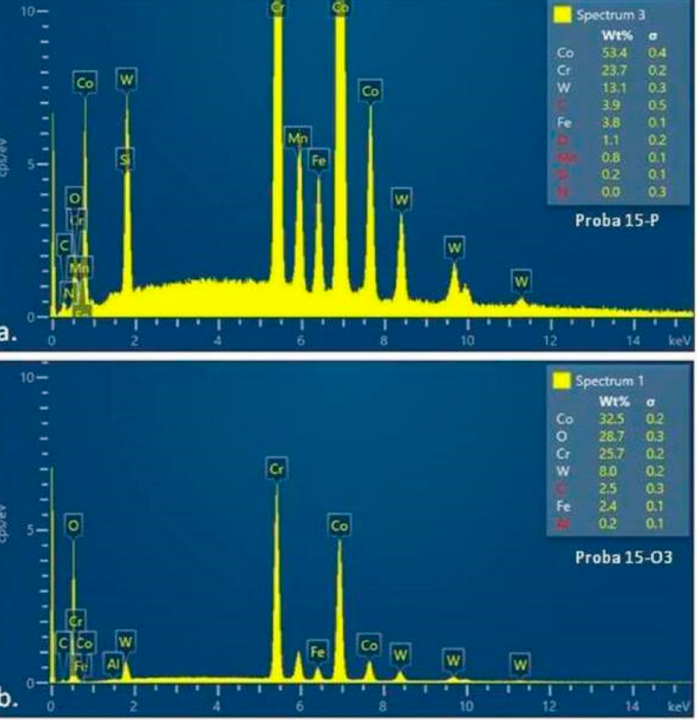
Figure 13. Diagram of EDS spectra with elemental analysis ( a ) sample 15-P (before heat treatment); ( b ) sample 15-O3 (after heat treatment).